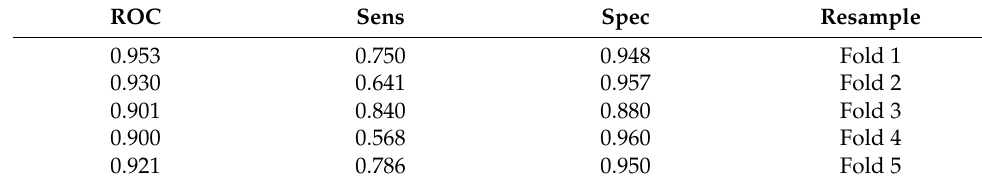
Table 4. Resampling performance.